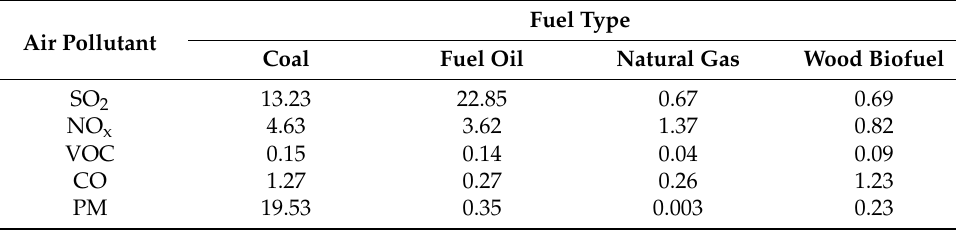
Table 2. Emission factors in line with fuel mass for different types of